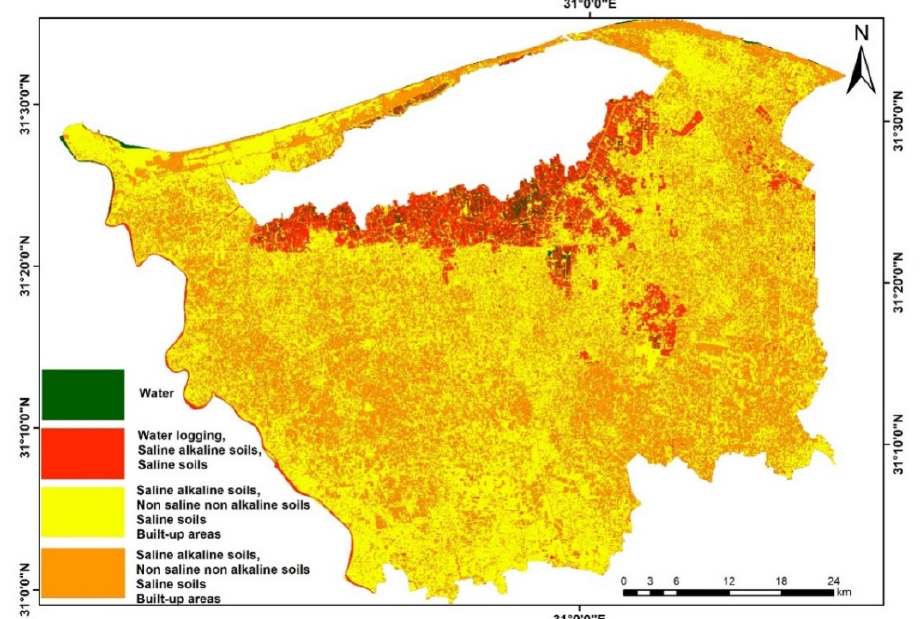
Figure 8 . A 2002 map showing the SAfSoil results from the indices of Khan et al. [71].